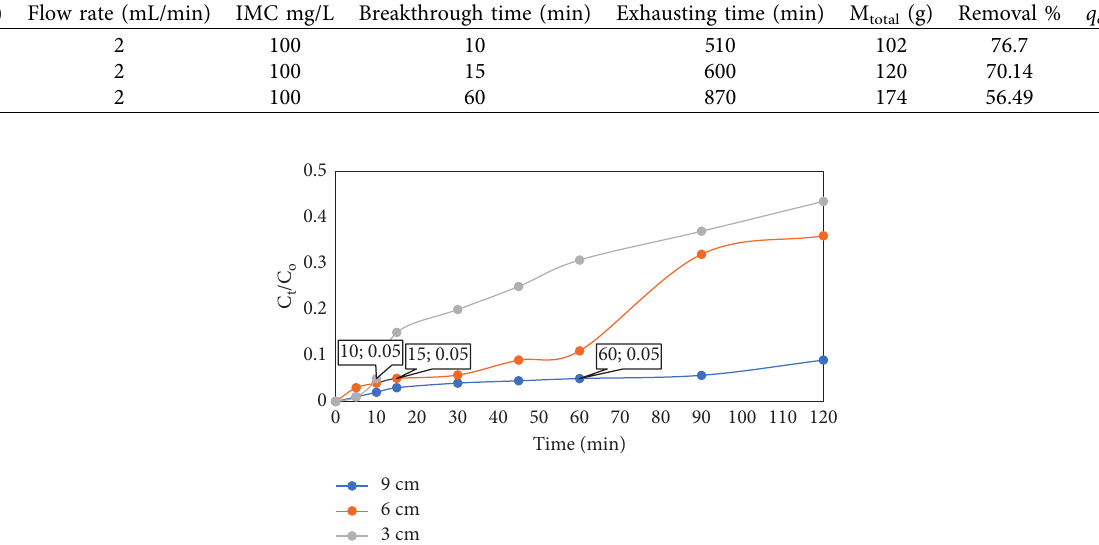
Figure 1: Breakthrough curve for adsorption of copper at different depths.